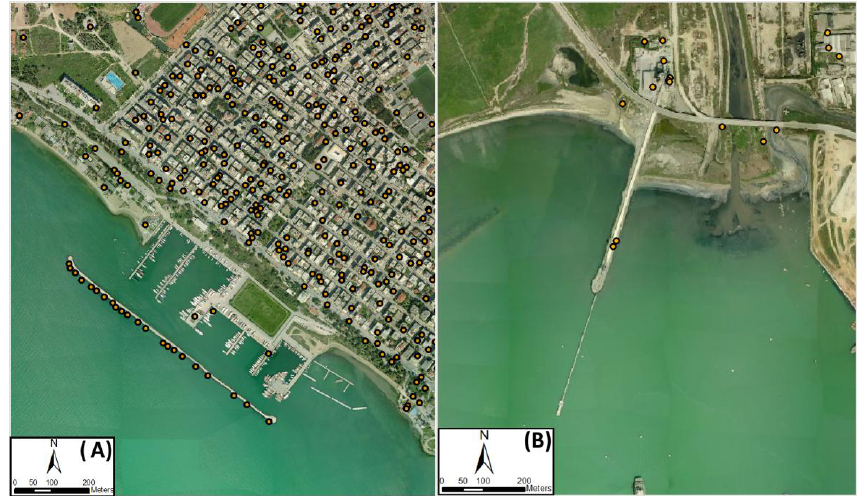
Fig. 4. Examples of the georeferencing accuracy of the WAP dataset: Thessaloniki breakwater (A) and Thessaloniki commercial harbour Figure 4. Examples of the georeferencing accuracy of the WAP dataset: Thessaloniki 817 pier (B) . breakwater (A) and Thessaloniki commercial harbour pier (B). 818